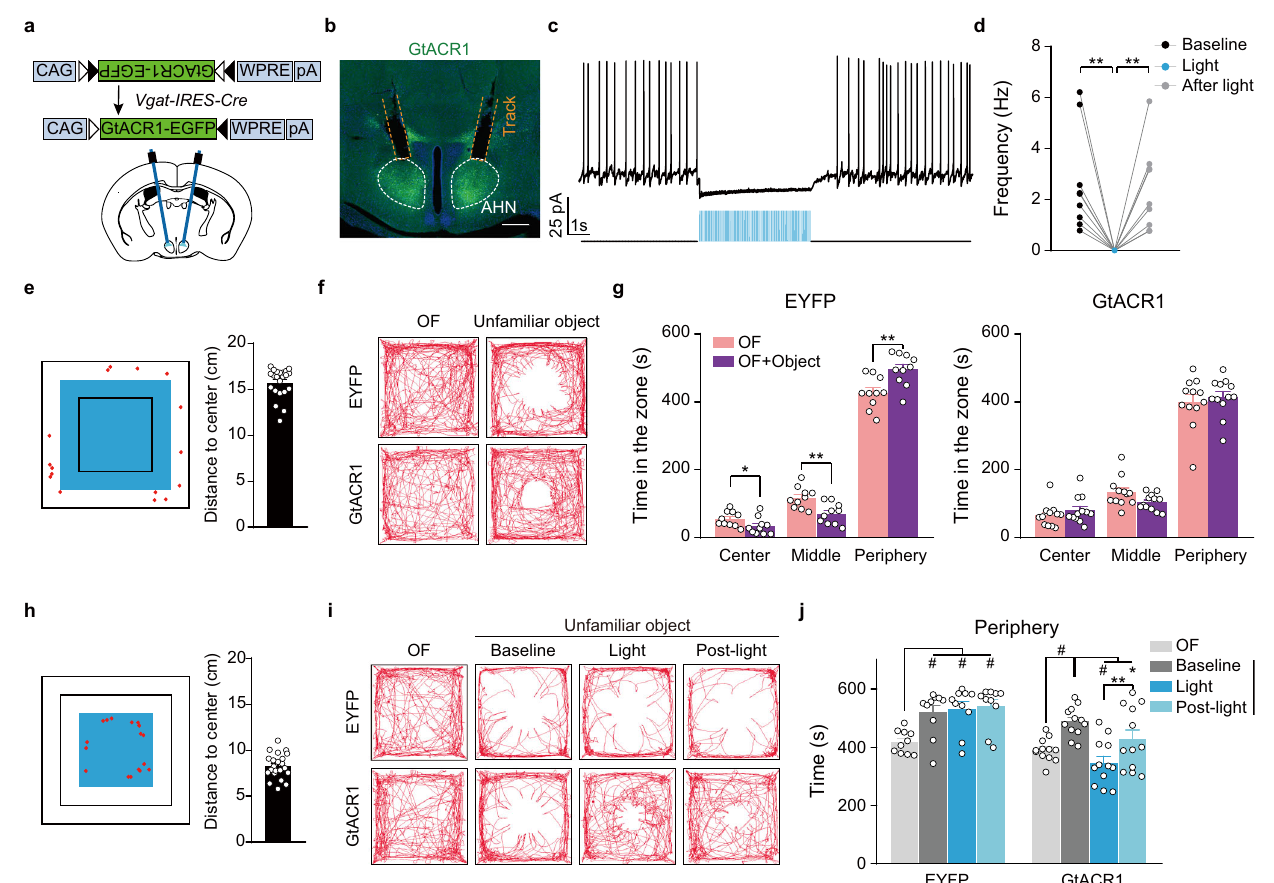
Fig. 3 | Optogenetic inhibition of object-evoked AHN Vgat+ activity reduces avoidance. a The viral strategy to optogenetically inhibit AHN Vgat+ neurons. b A representative post-hoc image showing GtACR1 expression in AHN and tracks of implanted fi bers. Scale bar, 200 μ m. c , d A representative trace ( c ) and quanti fi - cations ( d ) show light-mediated inhibition of GtACR1-expressing neurons. Wil- coxon matched-pairs signed rank test, baseline vs light, p =0.004, light vs after light, p =0.004. e – j Optogenetic inhibition of AHN Vgat+ neurons. e , h Light delivery areashownbythebluesquareforexperimentsin f , g and i , j ,respectively.Reddots denote the starting location of all approach ( e ) or retreat ( h ) bouts in a repre- sentative trial. The quanti fi cation on the right shows the average distance (in the vertical or horizontal direction) between the approach ( e ) or retreat ( h ) starting